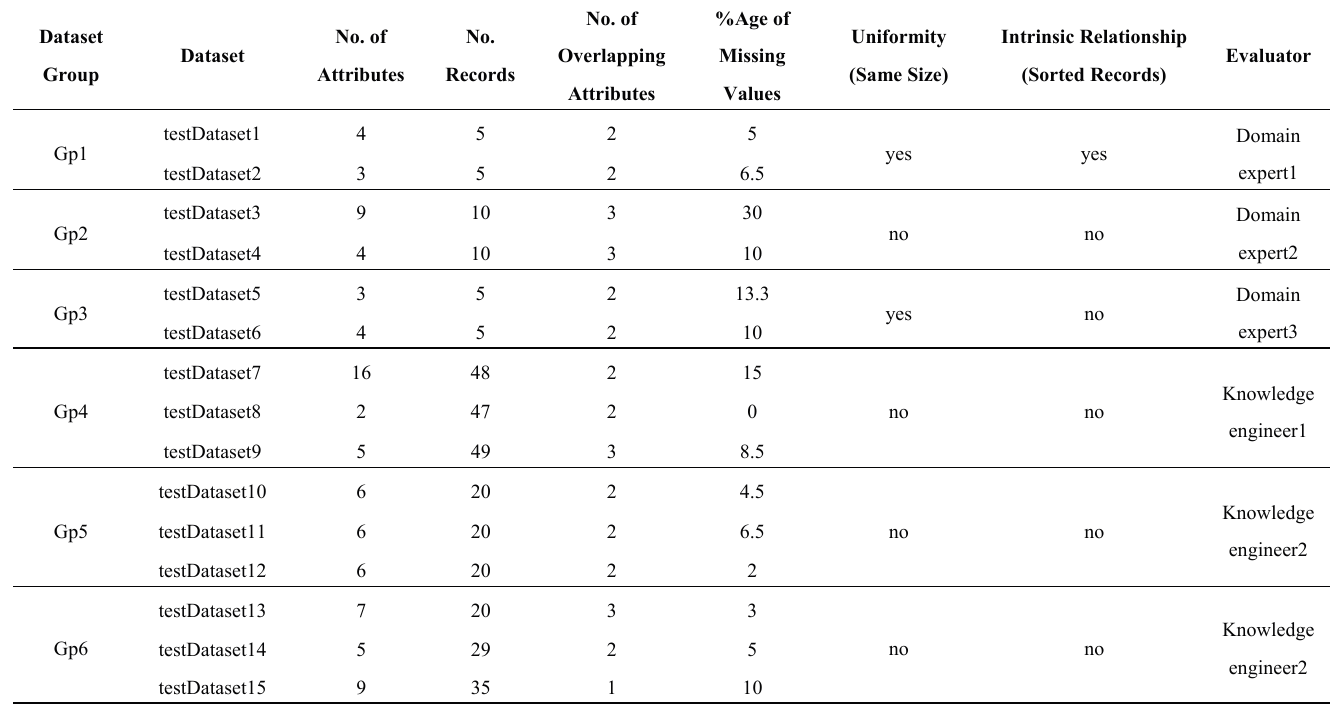
Table 4. Evaluation results of the data modeler in terms of time taken during unified dataset creation. Datasets